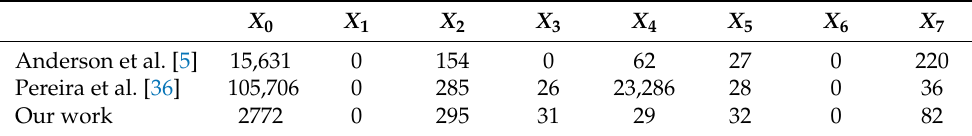
Table 6. Numbers of misidentified domains in the datasets.